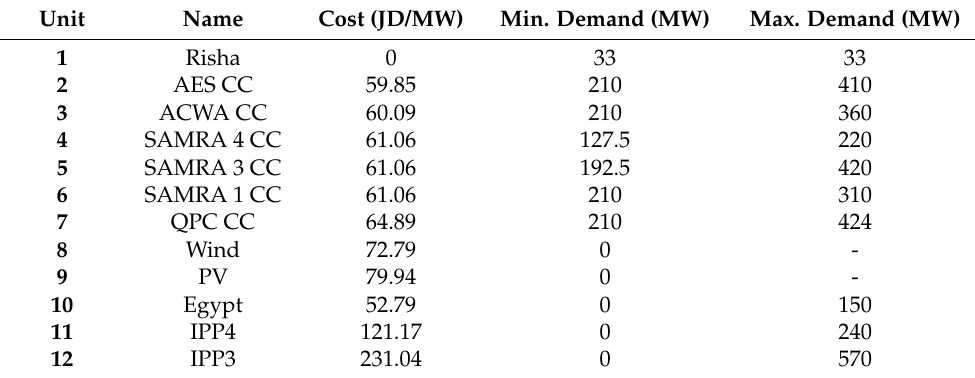
Table 13. Power plant dispatched for the case-study in December 2019.